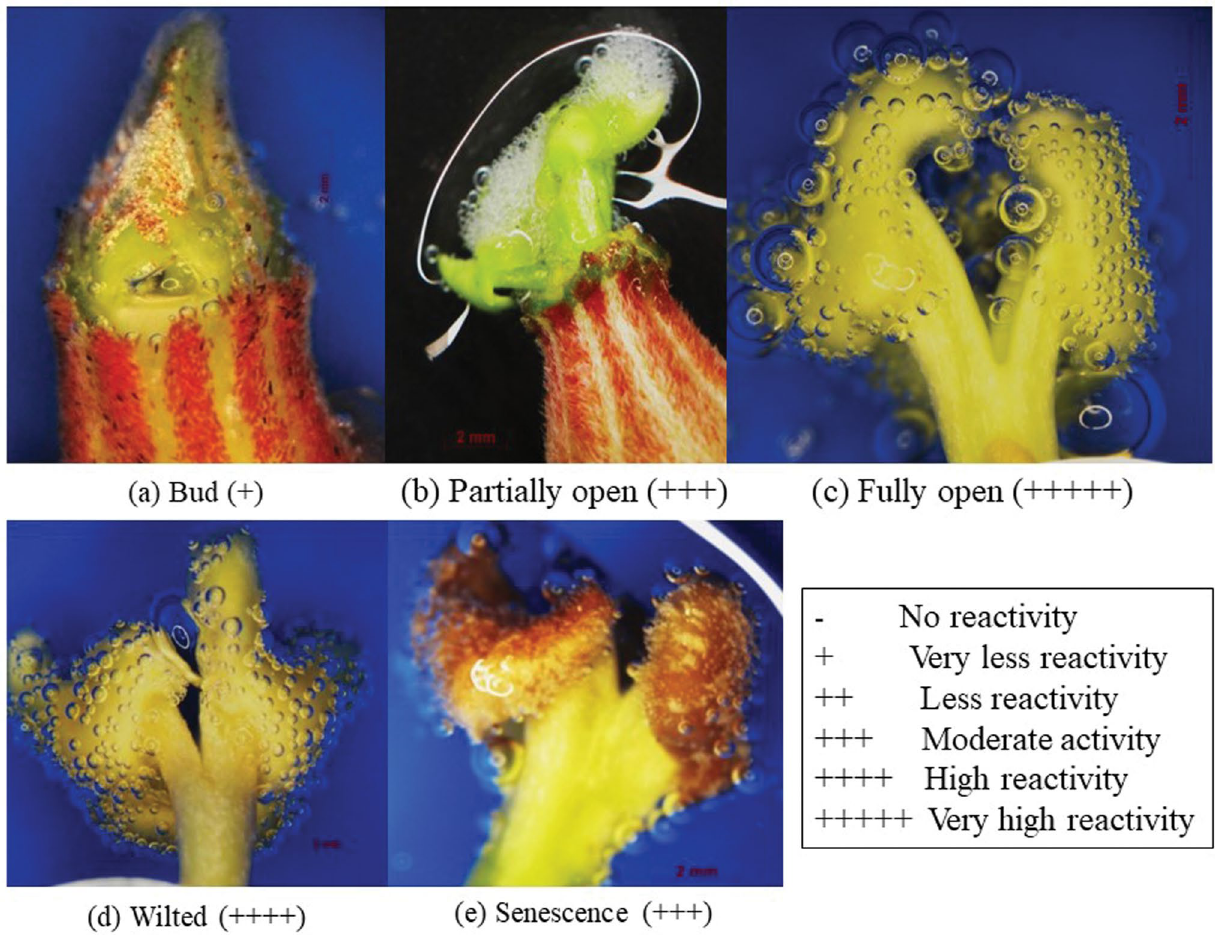
Figure 5. Microscopic view of stigma receptivity at different stages, bud (a) ; partially opened flower (b) ; fully opened flower (c) ; wilted flower (d) ; and senescent flower (e) .